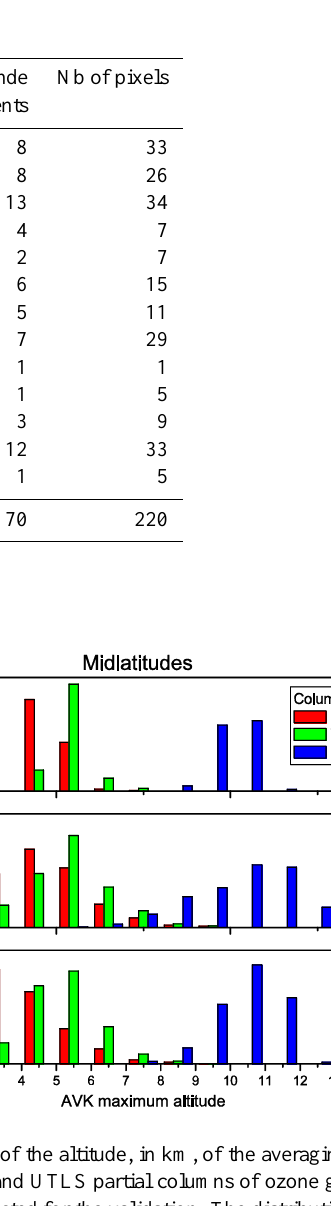
Table 3. Same as Table 2 but for the tropical ozonesonde stations.